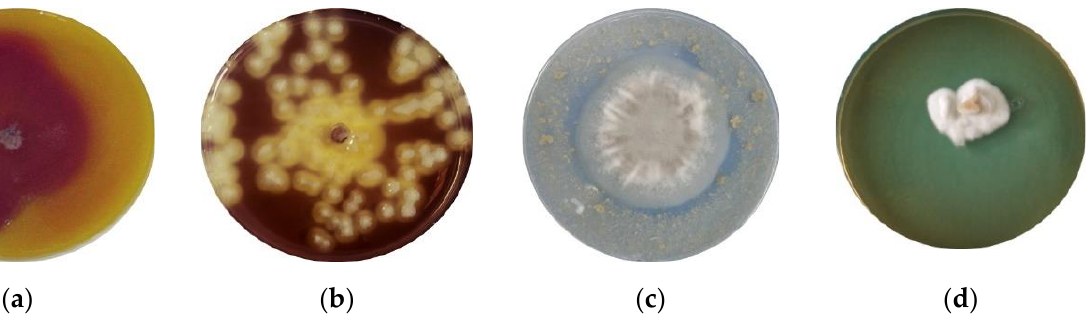
Figure 4. Formation of halos owing to production of hydrolytic enzymes and siderophores by Paecilomyces lilacinus on agar plates. ( a ) Chitinolytic activity (arrow—zone of enzymatic activity); ( b ) cellulolytic activity (brown color of medium, iodine staining of cellulose medium); ( c ) keratinolytic activity (arrow — clear zone of enzymatic activity); ( d ) production of siderophores on medium with 8-hydroxychinoline.